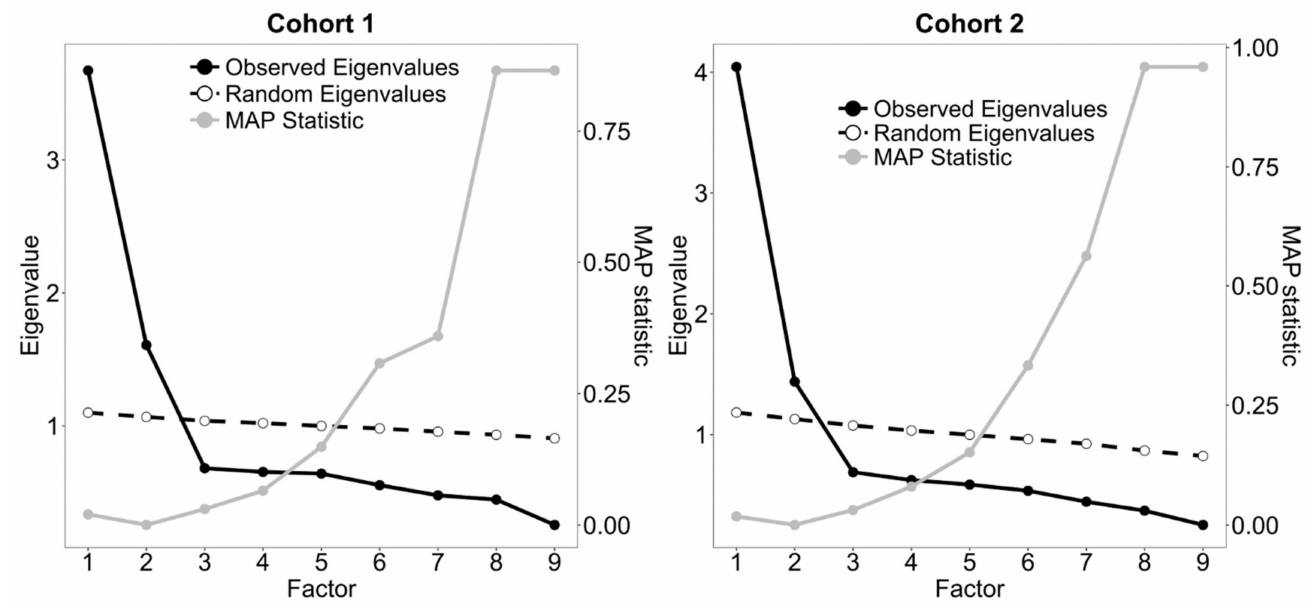
Figure 1. Score distributions and descriptive statistics for the items of the Work Annoyance Scale in the two cohorts (Cohort 1 n = 2226; Cohort 2 n = 655). M = mean; SD = standard deviation; SK = skewness; KU = kurtosis.